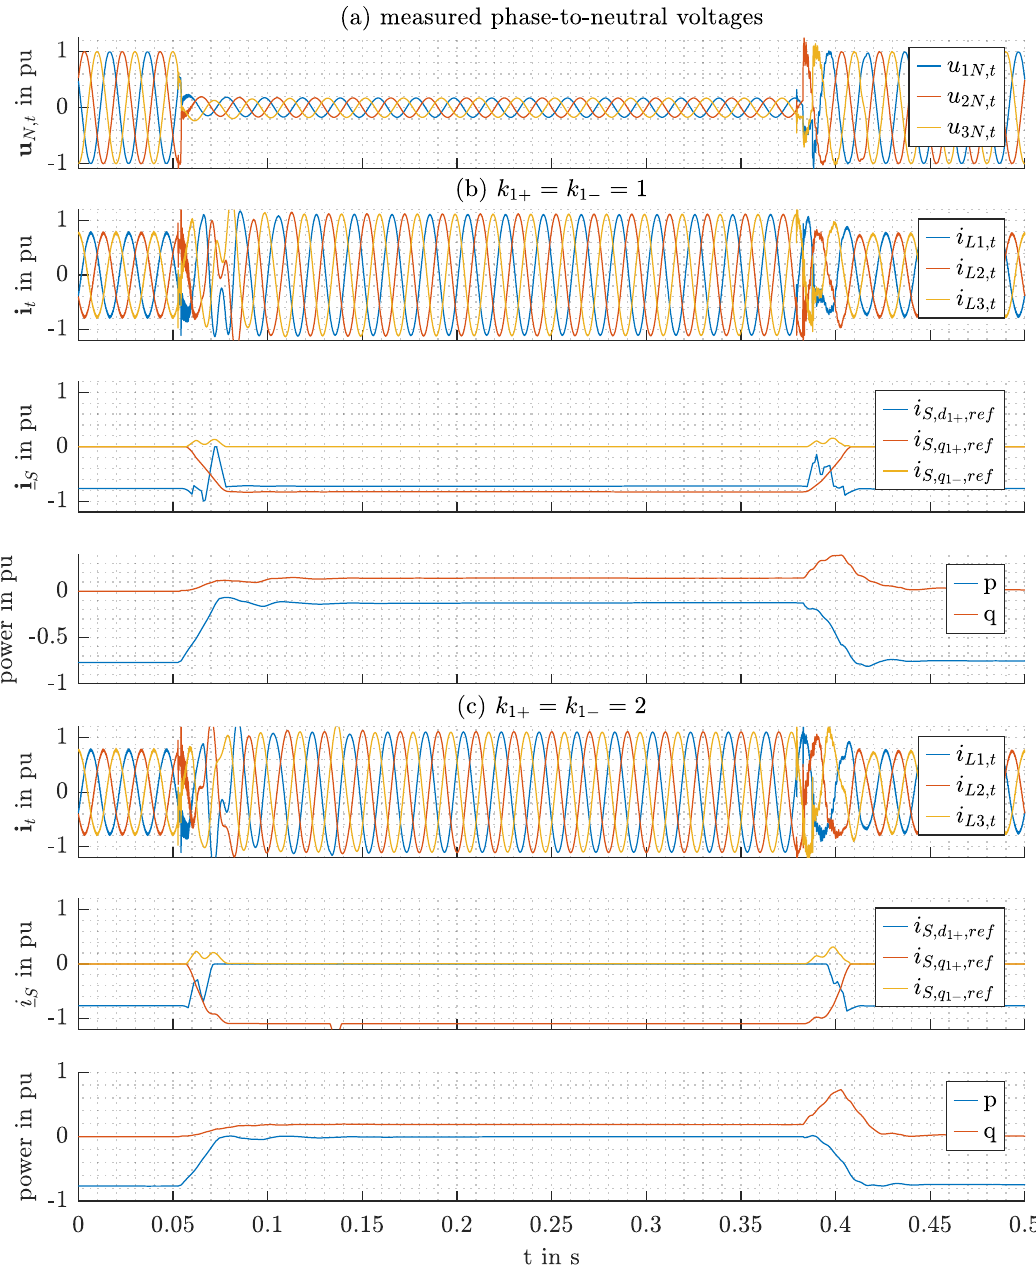
Figure 7. Simulation results of a three-phase short-circuit (the load reference system is